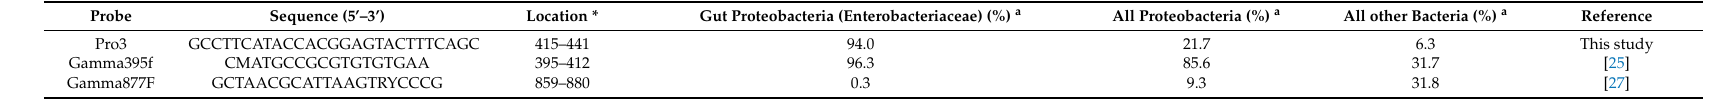
Table 5. Comparison of probes from the current study with previously reported Proteobacteria-specific probes.